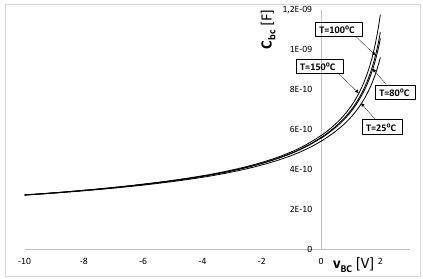
Fig.2. C bc (v BC ) characteristics of the BT1206-AC transistor in a range of the ambient temperature from 25 ° C to 100 ⁰ C.